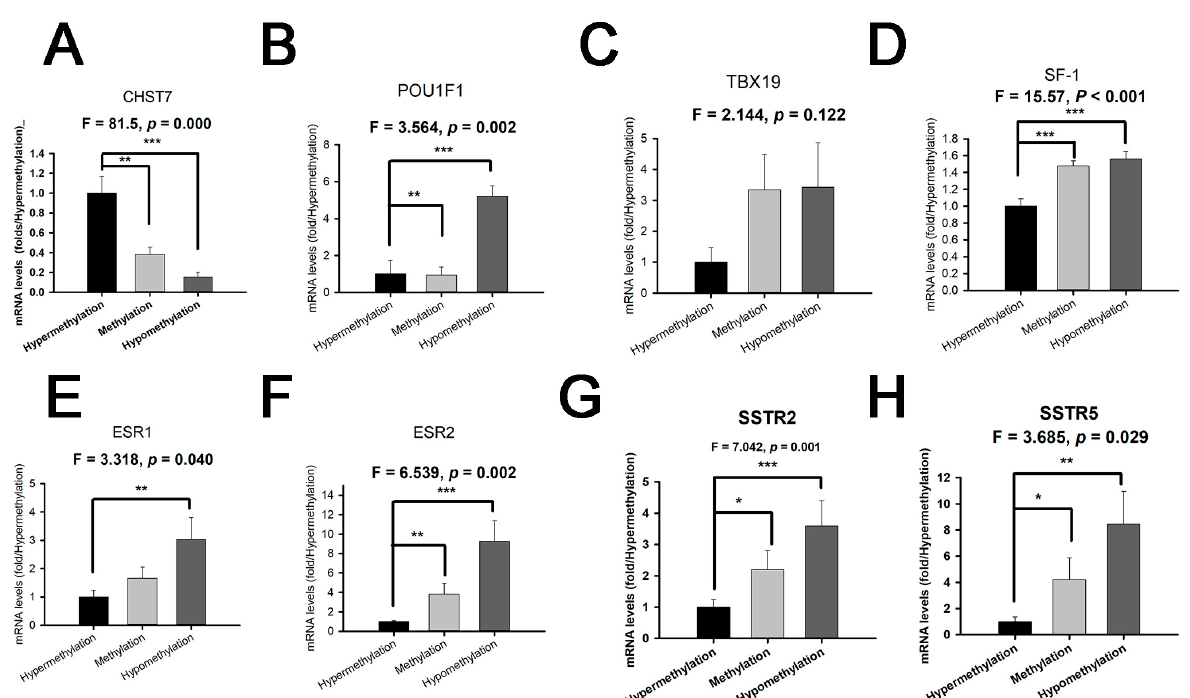
Figure 4. The mRNA levels of CHST7, transcription factors, and receptors grouped by different CHST7-promoter-methylation statuses. ( A ) CHST7. ( B ) Pit-1. ( C ) TBX19. ( D ) SF-1. ( E ) ESR1. ( F ) ESR2. ( G ) SSTR2. ( H ) SSTR5. Compared to the hypermethylation group: * p < 0.05; ** p < 0.01; *** p < 0.001.